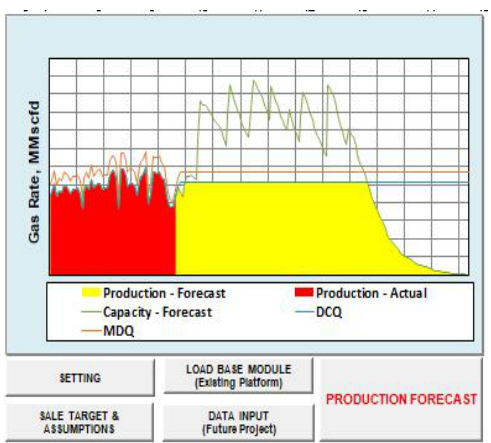
Figure 8—An interface of production forecast modelling.